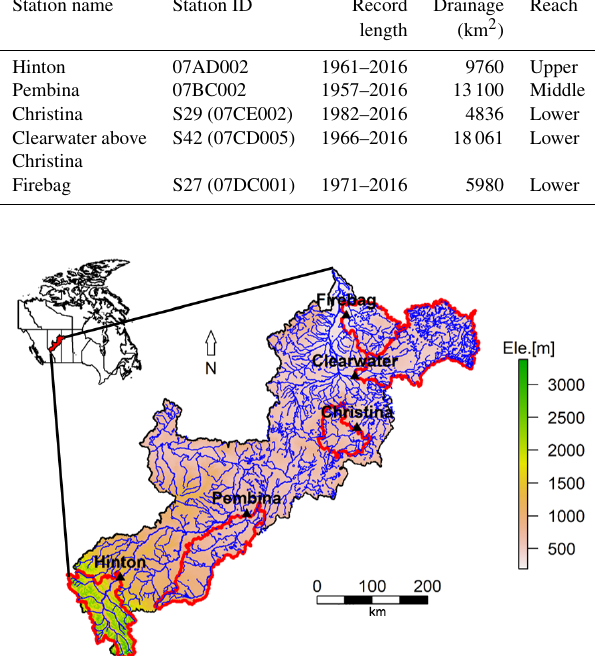
Figure 3. Geographical information on the five sub-basins (red line) selected in the Athabasca River basin for the proxy